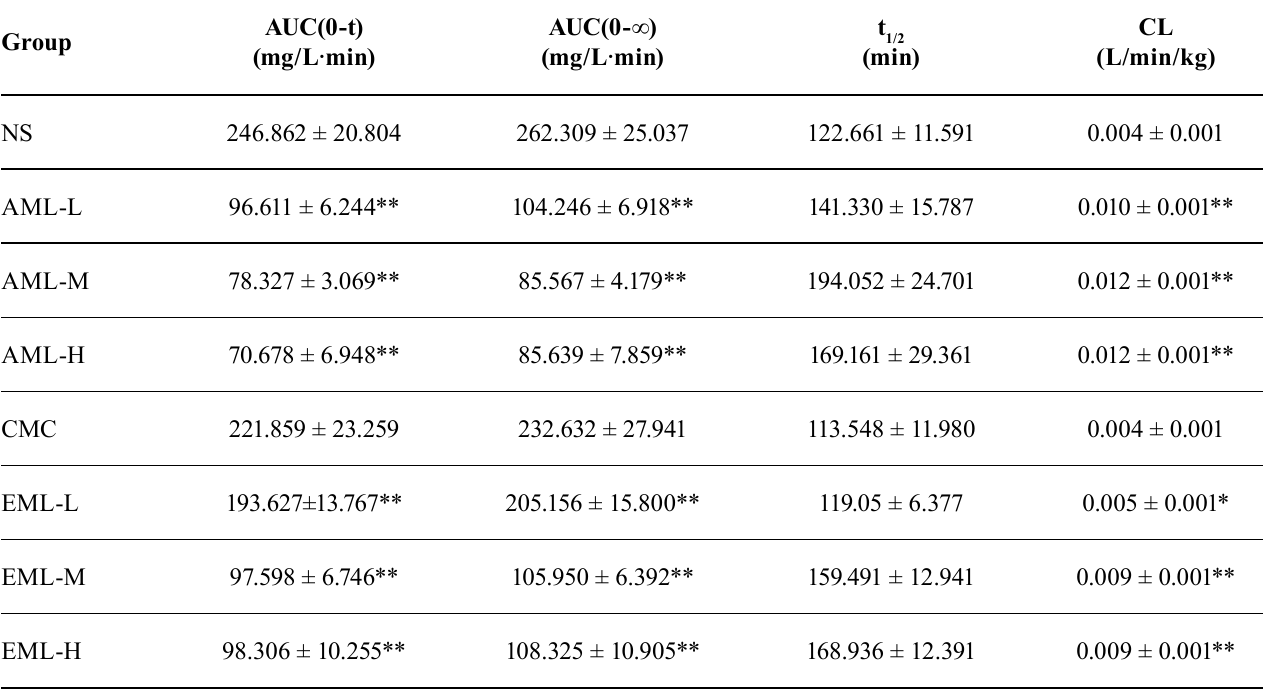
Figure 2. After pretreatment with all doses of AML, the main pharmacokinetic parameters (AUC AUC ) of midazolam in rats were significantly (0-∞) decreased, compared to those of the NS group, while CL was significantly increased. A similar trend of pharmacokinetic parameters was observed in the EML treatment groups, indicating that the metabolism of midazolam is highly accelerated. Thus, both AML and EML appear to have the potential to stimulate rat hepatic CYP3A4 activity in vivo